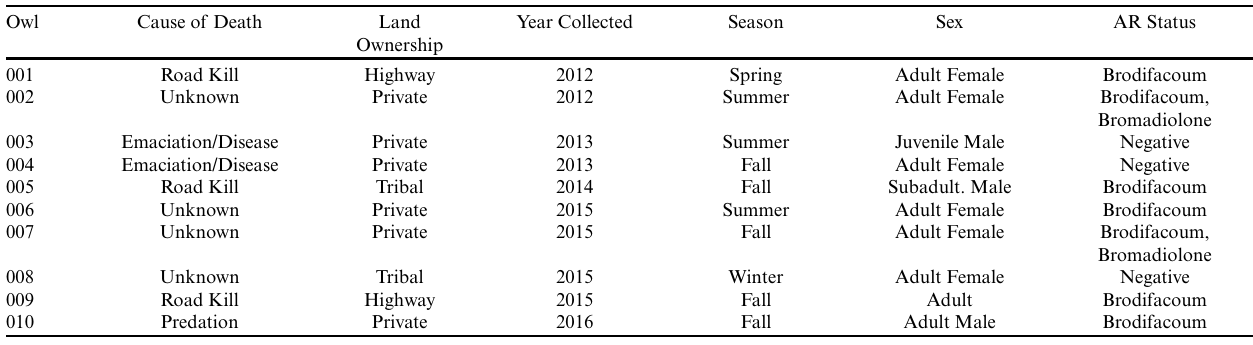
Table 1 . Results of Northern Spotted Owls ( Strix occidentalis caurina ) anticoagulant rodenticide exposure, cause of death, location of collection, year and season of collection, and the sex of the individual from both Humboldt and Mendocino Counties in Northwestern California,